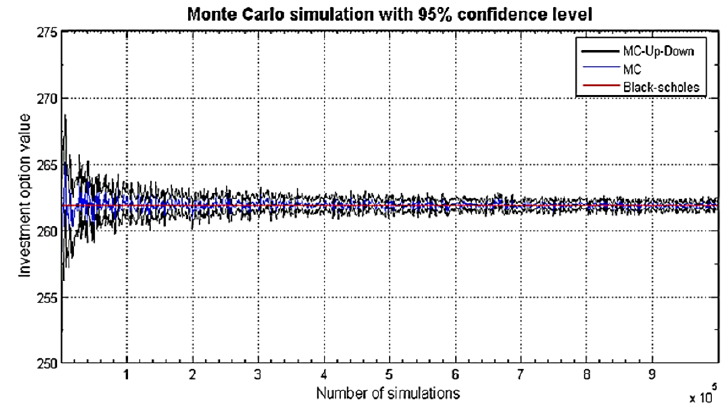
Figure 8. The value of the investment option (blue) and the 95% confidence level with an MC simulation in comparison to the analytical solution (red).